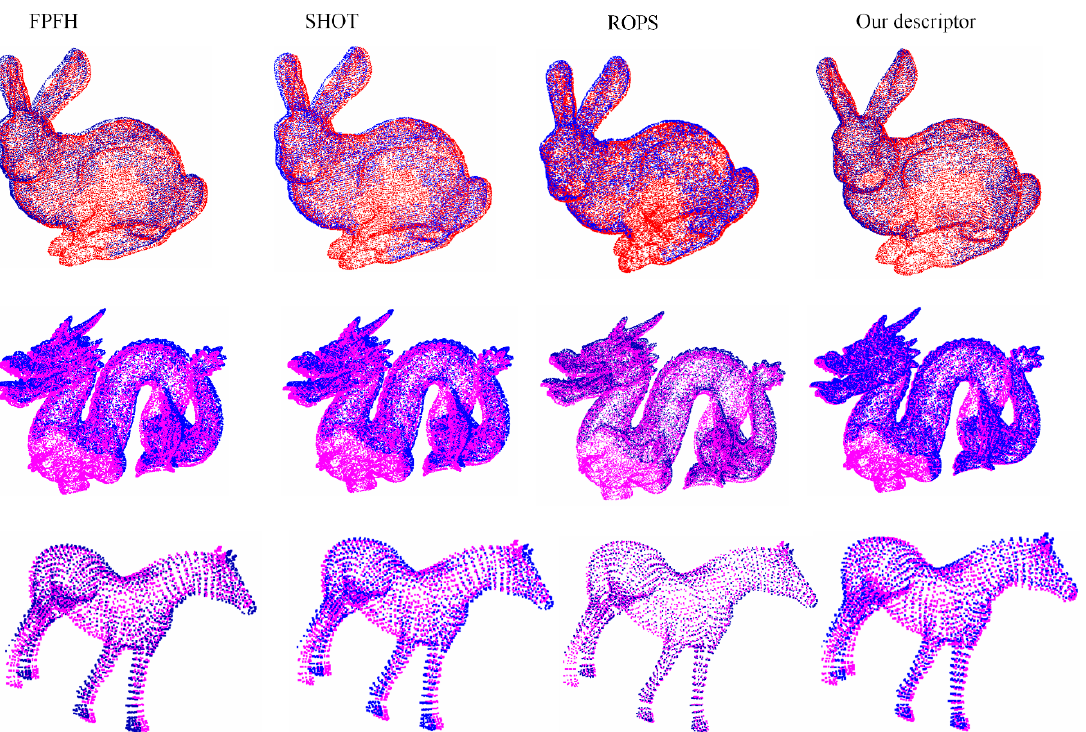
Figure 8. Comparison PCR results based on four descriptors, and the overlap ratio is 0.6. The overlap is measured with respect to the surface area. From left to right is the result of FPFH, SHOT, RoPS, and our descriptor, respectively. From top to down is the Bunny, Dragon, and Horse point cloud, respectively. The source point cloud is shown in blue, and the target point cloud is shown in red.